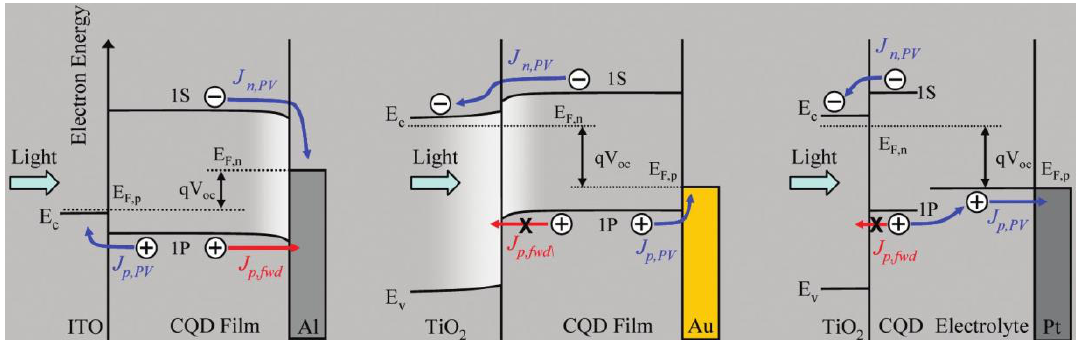
Figure 4. A compilation of the band diagrams of the three common PbS QDSCs configurations. The leftmost configuration depicts a Schottky junction solar cell where charge carrier separation and extraction occur at the rear junction, between the PbS QD layer and the metal electrode. The middle configuration shows a depleted heterojunction solar cell in which the TiO 2 nanoparticles-PbS QD layer interface forms the main junction where charge extraction and separation takes place. The rightmost configuration shows a QD-sensitized device in which the differences in electron affinity between the TiO 2 and the PbS QD layer causes charge separation. Reproduced with permission from reference [172], copyright 2010 American Chemical Society.